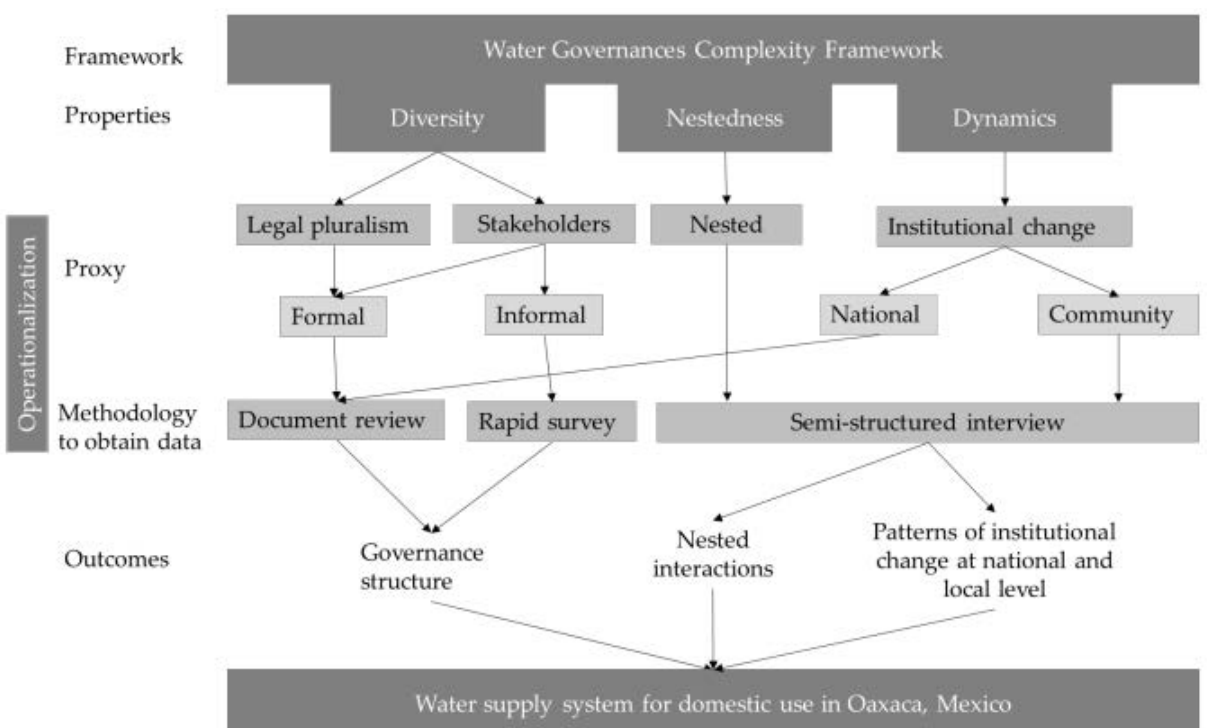
Figure 3. Scheme of the operationalization of the Water Governance Complexity Framework, the proxies used to address them, the methodology implemented to obtain data, and expected outcomes, using the case of the water supply system for domestic use in Oaxaca,